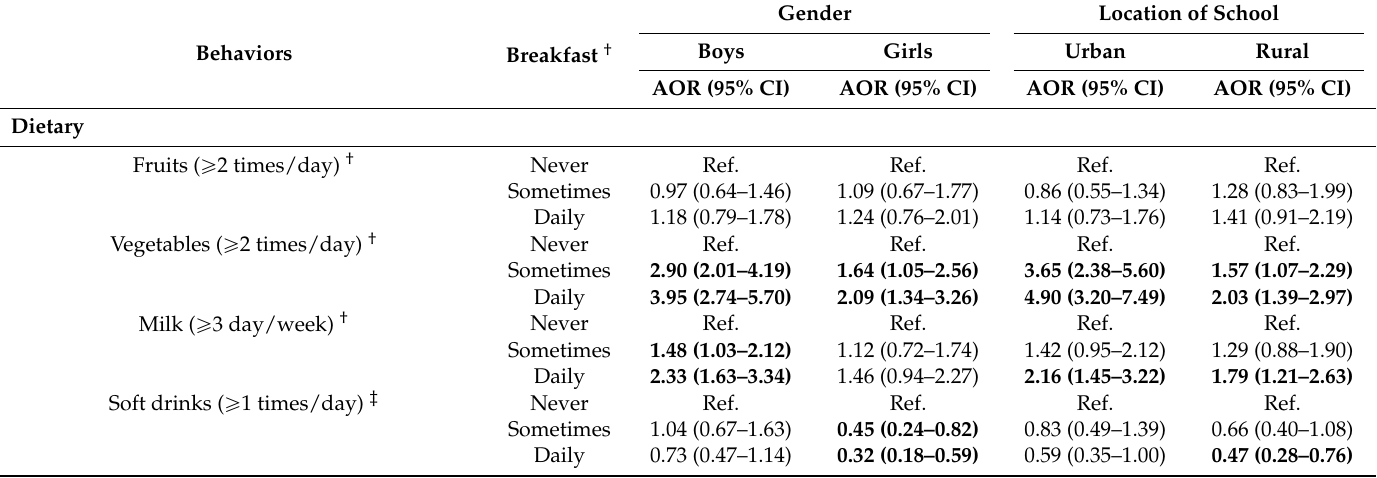
Table 4. Breakfast consumption and its associations with health-related behaviors stratified by gender and location of school.